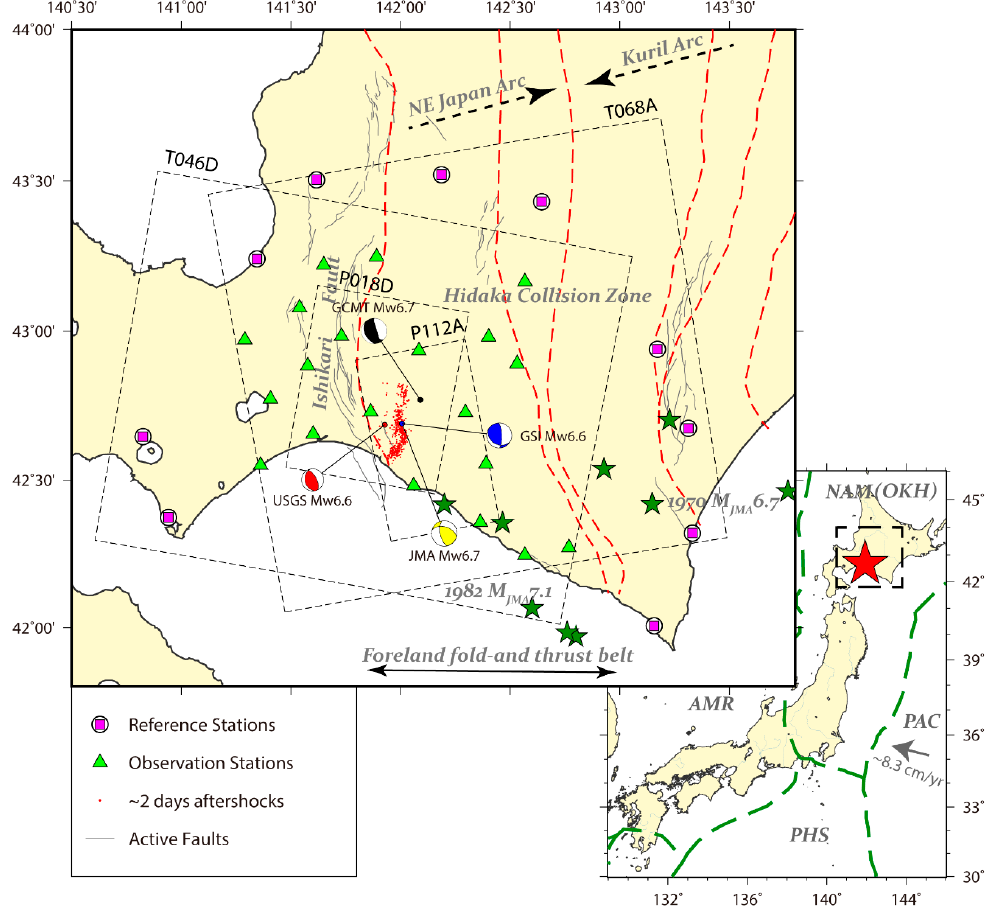
Figure 1. Map of the tectonic setting of the 2018 Hokkaido eastern Iburi earthquake. The focal mechanisms from four different institutions are shown for comparison. The mapped coverage areas of ascending (T068A and P112A) and descending (T046D and P018D) track interferometric synthetic aperture radar (InSAR) frames are shown in black dashed boxes. The dark green pentagrams represent M > 6.5 earthquakes from 1922. Red dashed lines denote the tectonic boundaries of Hokkaido based on Kimura [5], and the plate boundaries (green dashed lines) are from Bird [6]. AMR: Amurian plate; NAM: North American plate; OKH: Okhotsk plate; PAC: Pacific plate; PHS: Philippine Sea plate.